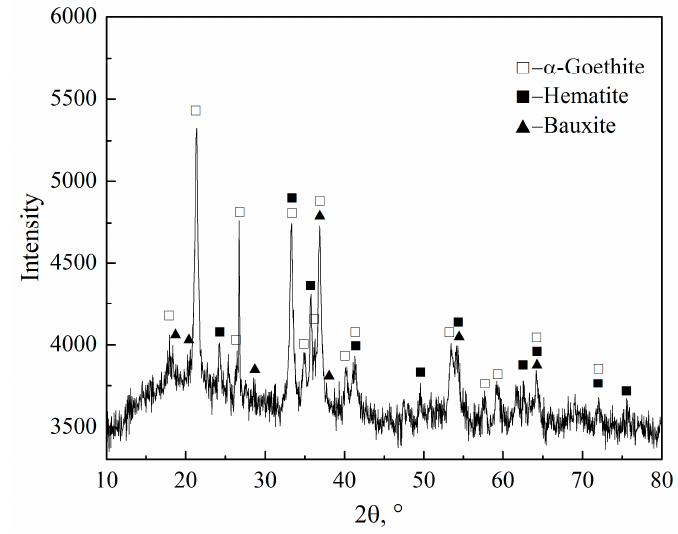
Figure 4. XRD analysis of the red mud.